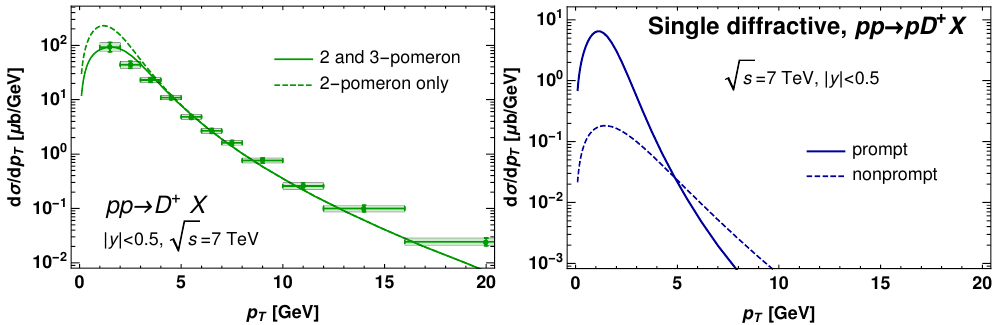
Figure 1: The D + -meson production cross-section as a function of transverse momen- tum p . Left and right plots correspond to inclusive and single diffractive production T at central rapidities respectively. As explained in the text, the three-pomeron contri- bution in left-hand side is not positively defined due to interference diagrams, so its inclusion decreases the overall result. The experimental data are from [ 31–33 ]